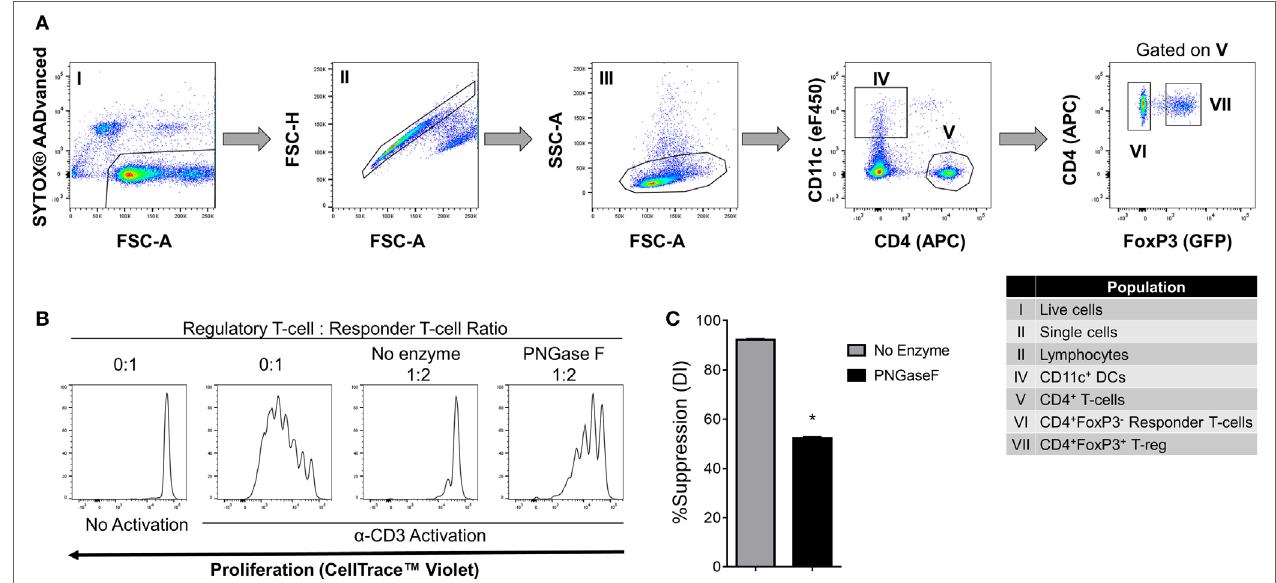
FigUre 8 | Suppression of CD4 + responder T-cell proliferation by PNGase F-treated Treg in the presence of dendritic cells (DC). (a) Gating strategy for purification of CD11c + DCs, CD4 + Tconv, and Treg from C57BL/6 FoxP3.EGFP mouse spleen and lymph nodes. Individual sorted populations are identified by Roman numerals and described in the text box. (B,c) Fluorescence-activated cell sorting (FACS)-purified CD4 + Tconv were cocultured in the presence of FACS-purified CD11c + DCs without Treg (0:1) and with no enzyme or PNGase F-treated Treg at Treg: responder T-cell ratio 1:2 for 4 days with anti-CD3 stimulation. (B) Proliferation of CellTrace ™ Violet-labeled CD4 + Tconv analyzed by flow cytometry at the end of the culture period. (c) Graph of the suppressive potency of no enzyme and PNGase F-treated Treg on CD4 + Tconv. Suppressive function was quantified based on Tconv division index (DI) and presented as the calculated percent suppression [%Suppression (DI)]. Data represent mean ± SD ( n = 3 technical replicates). The experiments shown in panels (B,c) are representative of three independent experiments with consistent results. Statistical analysis was performed by permutation test with an unpaired design (* p value ≤